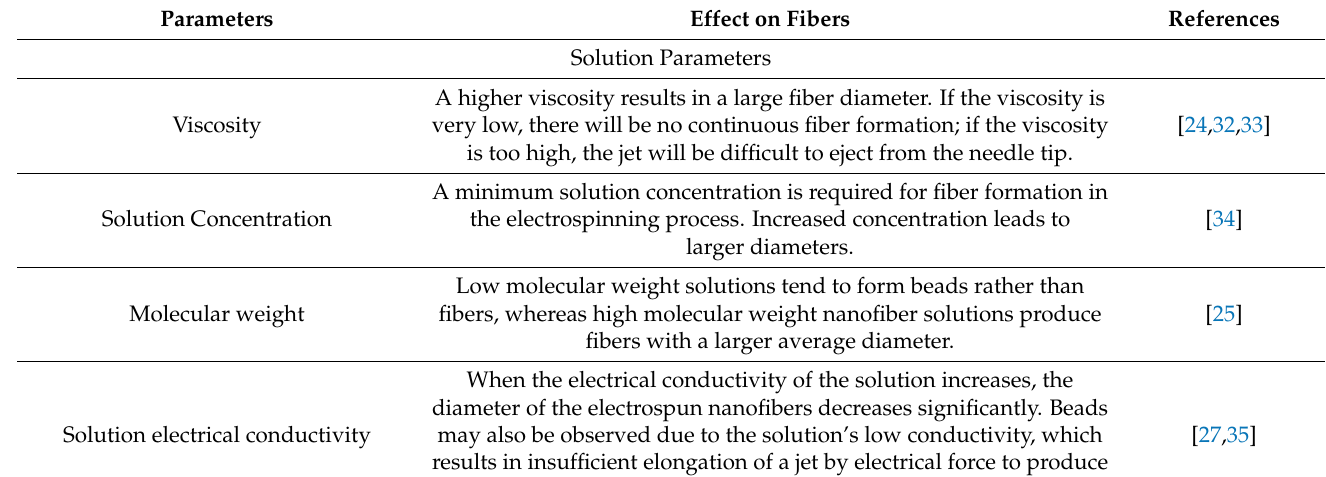
Table 1. Effecting parameters of